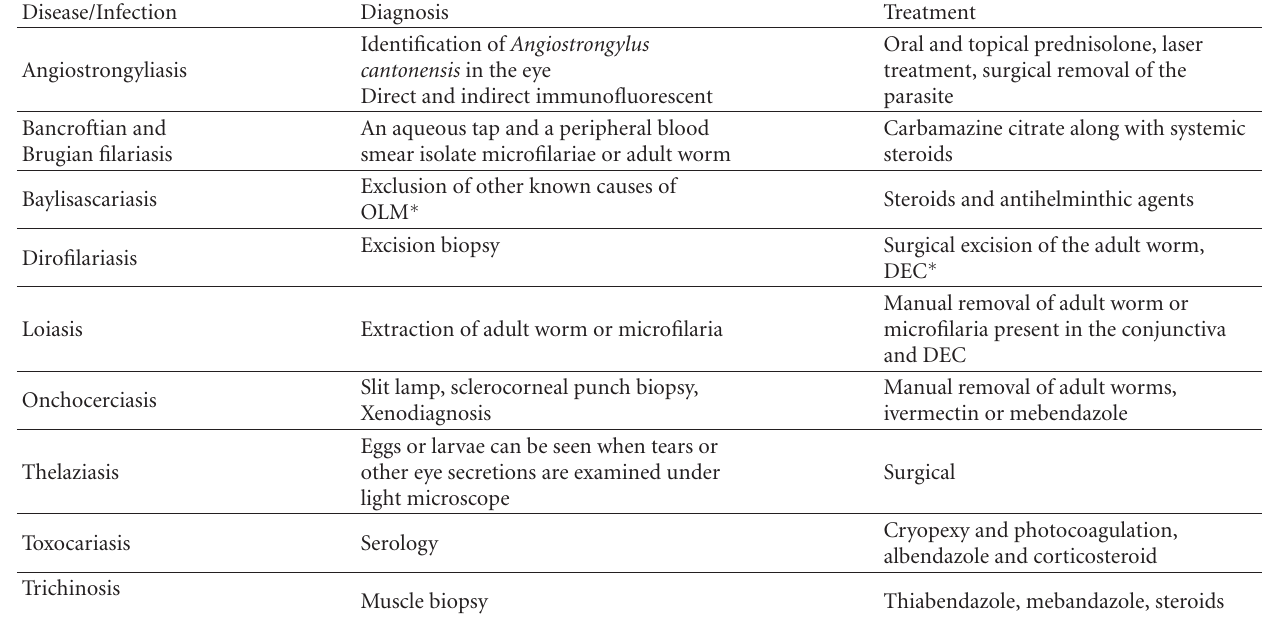
Table 4: Ocular parasitosis caused by round worms ( diagnosis and treatment